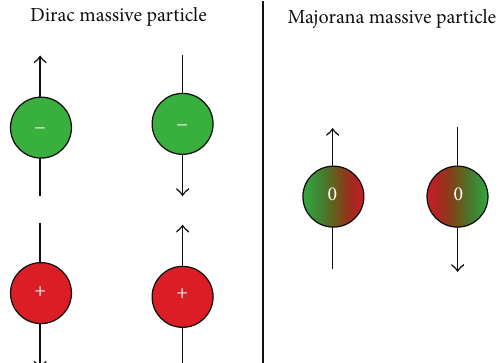
Figure 2: Massive fields in their rest frames. The arrows show the possible directions of the spin. (Left) the 4 states of Dirac massive field. The signs indicate the charge that distinguishes particles and antiparticles, for example, the electric charge of an electron. (Right) the 2 states of Majorana massive field. The symbol “zero” indicates the absence of any 𝑈(1) charge: particles and antiparticles